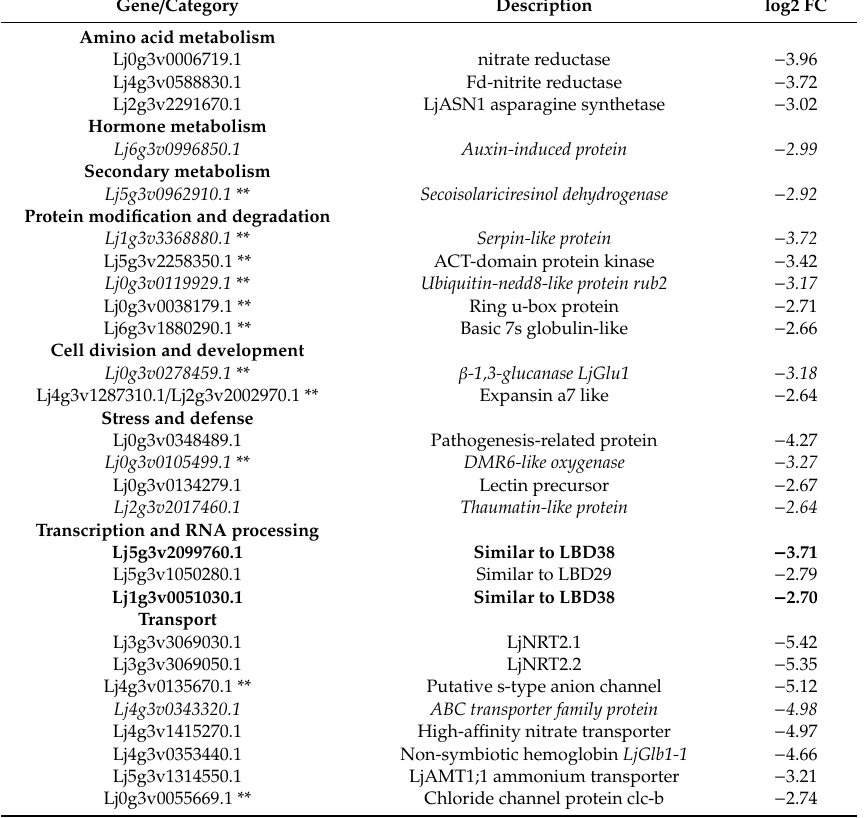
Table 2. Genes downregulated in roots of Nod plants compared to roots of NN plants. The fold change (FC) in expression levels is expressed as the log 2 of the di ff erence in relative expression levels of Nod–NN. When two di ff erent gene codes are reported, it means that both of them were recognized by the probeset due to very high homology. Genes without a previously proposed role in nodule function and / or development are highlighted with two asterisks. Italic font is used to highlight the genes that belong to the secondary (smaller) cluster according to the analysis carried out (left cluster in Figure 3). Genes that cluster together with known L. japonicus regulatory genes are highlighted in